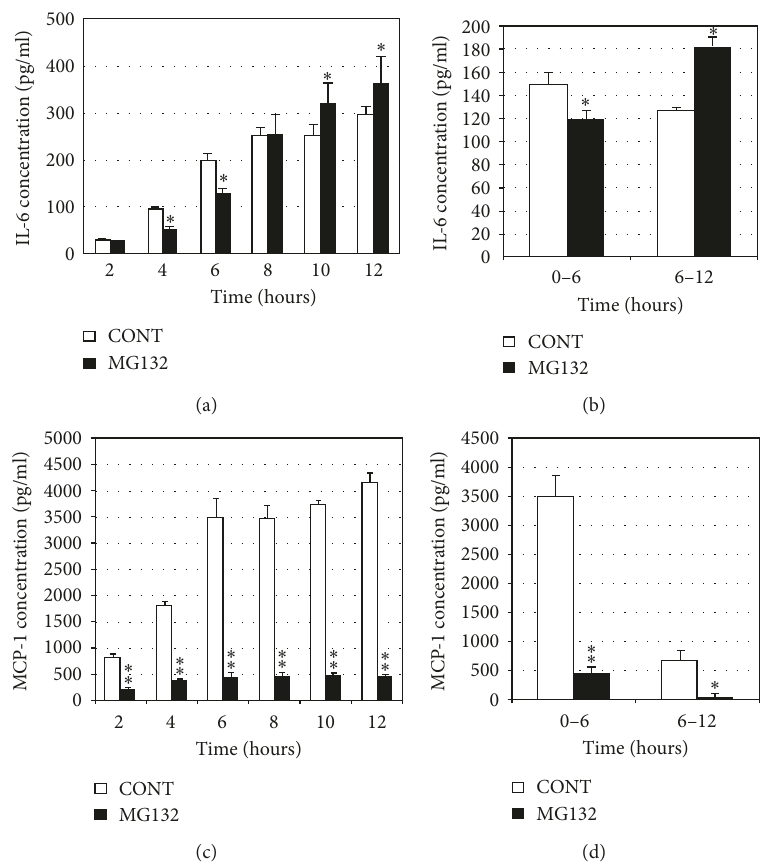
Figure 2: Protease inhibitor MG132 upregulated the protein level of IL-6 in the medium of RPE in MG132 group compared with that in the control group, but it reduced the secretion of MCP-1. (a) Levels of IL-6 in the medium were detected by ELISA following incubation of ARPE-19 cells in the presence or absence of MG132 (10 μ M) for 2, 4, 6, 8, 10, or 12h. (b) Levels of IL-6 in the medium were detected by ELISA during 0 h–6h or 6h–12 h in the presence or absence of MG132 (10 μ M). (c) Levels of MCP-1 in the medium were detected by ELISA following incubation of ARPE-19 cells in the presence or absence of MG132 (10 μ M) for 2, 4, 6, 8, 10, or 12h. (d) Levels of MCP-1 in the medium were detected by ELISA during 0h–6h or 6h–12 h in the presence or absence of MG132 (10 μ M). The results are the mean ± SD ∗ p < 0 . 05 and ∗∗ p < 0 . 01 as compared with the control. 8CONT 1 2 4 8 1 2 4